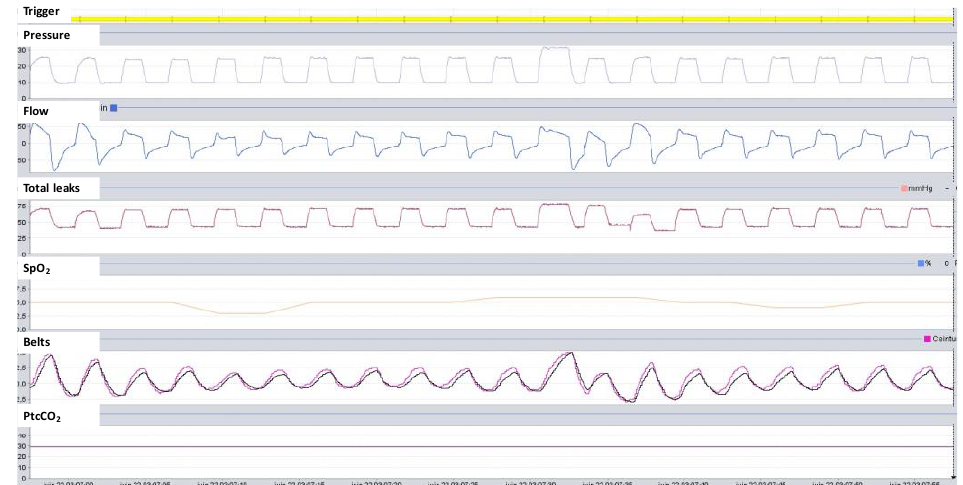
Figure 9. Example of respiratory polygraphy when the belts are connected directly to the ventilator. The ventilator built-in software display from top to bottom: breath trigger color code, pressure, flow, total leaks, SpO 2 , effort belts (thoracic belt in pink and abdominal belt in black), and transcutaneous capnography measured by an external device connected to the ventilator.